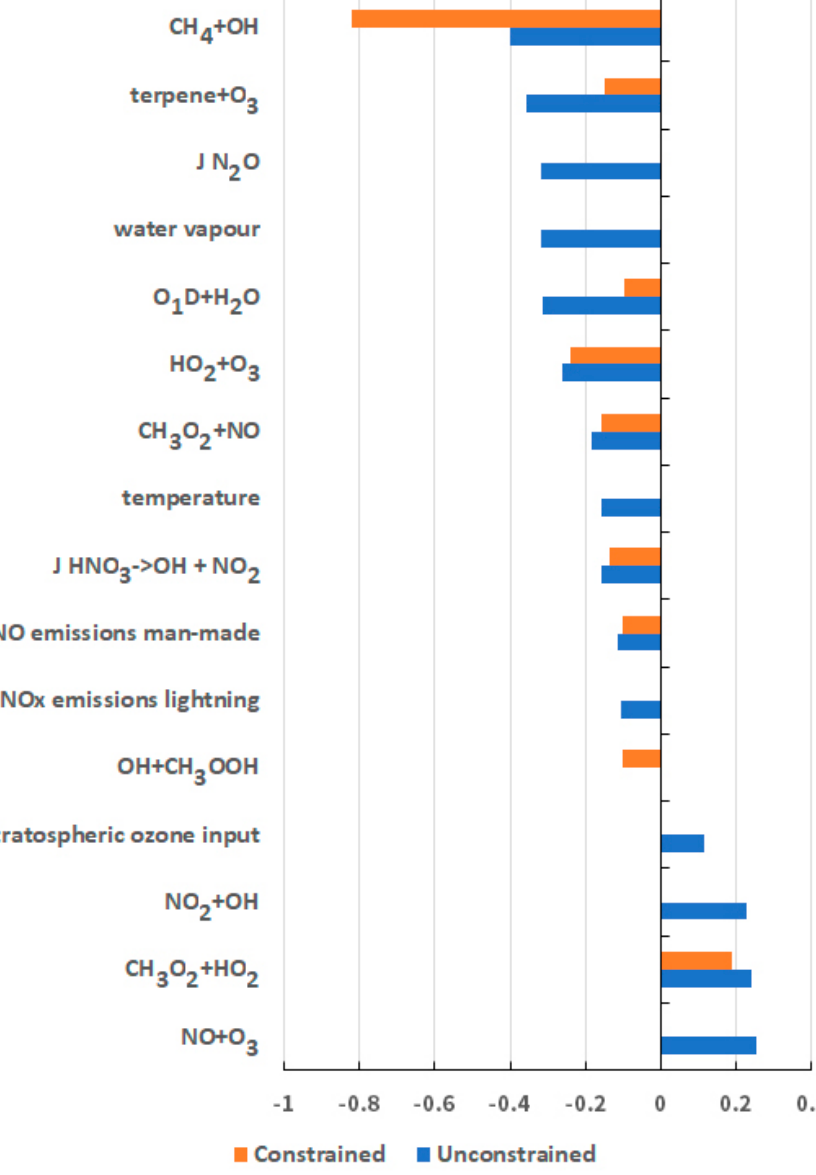
Figure 4. Partial correlation coe ffi cients from the multiple linear regression analyses of the GWP for CH 4 on the 183 uncertain model input parameters in the unconstrained Monte Carlo replicates (blue bars) and those with CH 4 lifetimes constrained in the range 11.2 ± 1.3 years (red